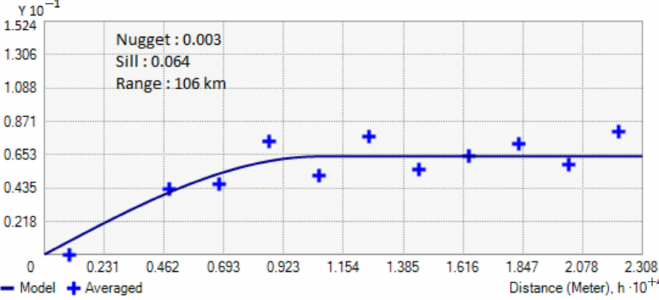
Figure 3. The Spherical semivariogram model of the OK interpolation is fitted on the pre ‐ monsoon GWL data of 2008.